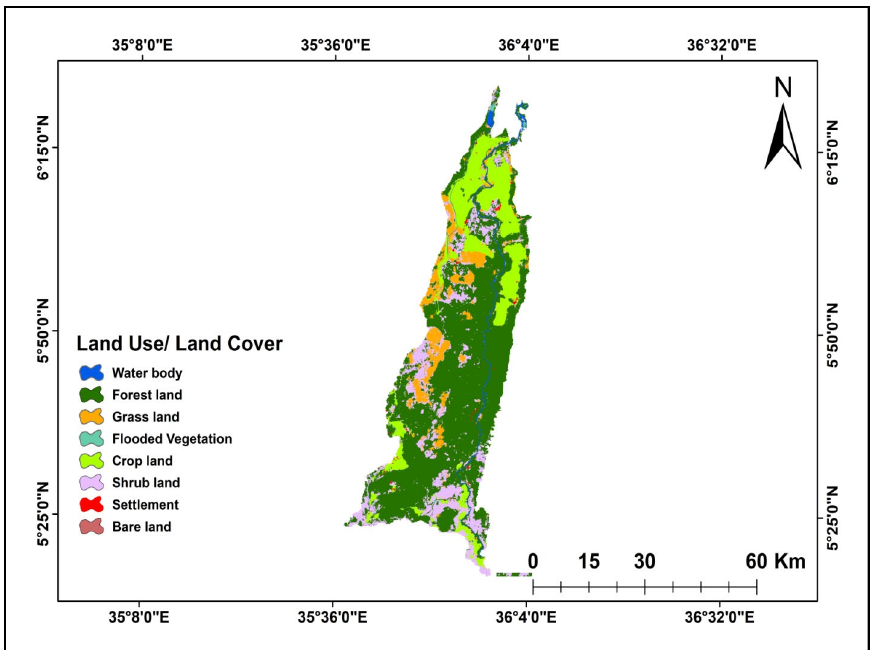
Figure 3. Land use/land cover types of the study area .